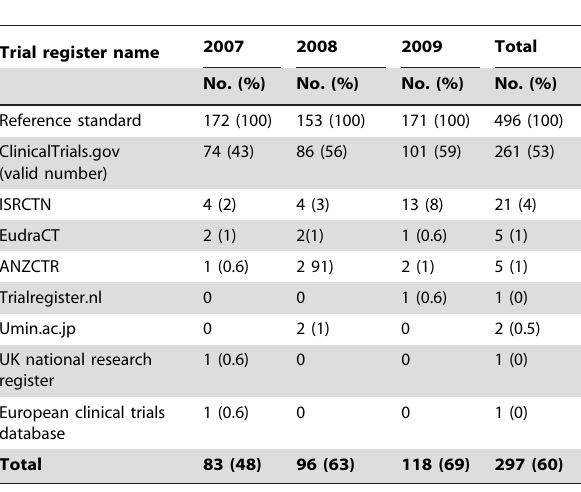
Table 4. Trial register names provided by authors for randomized trials by